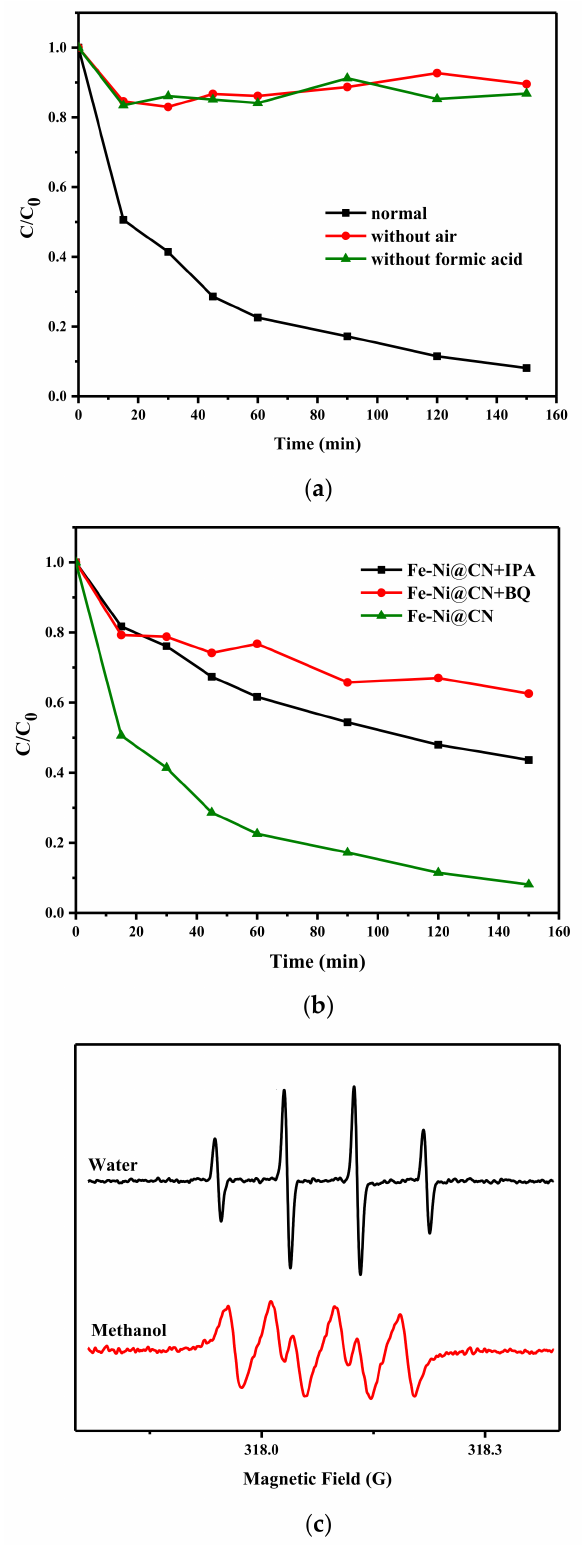
Figure 7. ( a ) Degradation of FeNi-Pd@CN in different environments (AR 73 200 mg/L), ( b ) the H 2 O 2 production ability over as-prepared catalysts, and ( b ) effect of IPA, BQ on the AR 73 degradation efficiency. ( c ) ESR DMPO- • OH and methanol- • O 2 − spectra of FeNi-Pd@CN catalyst (catalyst dosage: 2 g/L; FA: 46.6 mmol/L; air; 200